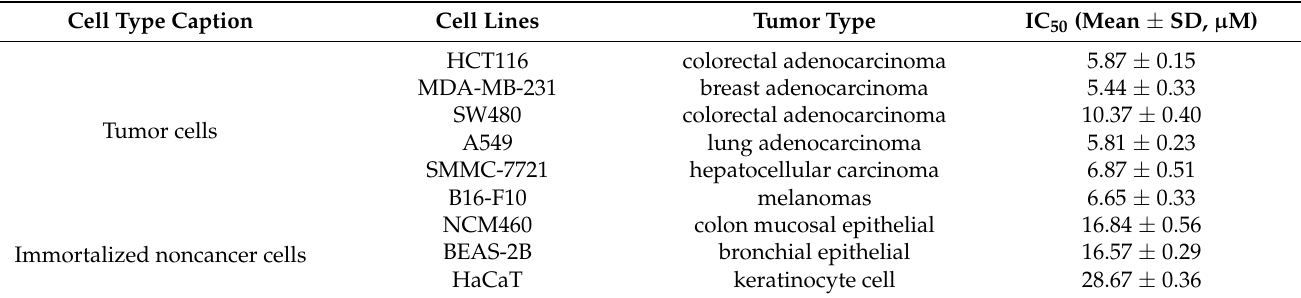
Figure 2. Brevinin-1RL1 preferentially suppressed cancer cells. The cell viability of Brevinin-1RL1 on different tumor cell lines (HCT116, MDA-MB-231, SW480, A549, SMMC7721, B16-F10) ( a ) and three non-tumor cell lines (HaCaT, NCM460 and BEAS-2B) ( b ) were determined by MTS assay. Tumor cells seeded in 96-well plates were incubated with various concentrations of Brevinin-1RL1 for 48 h and the cell viability was measured by MTS. ( c ) The cell viability of tumor cell lines treated with various concentrations of Brevinin-1RL1 red was measured. ( d ) The erythrocyte viability of Brevinin-1RL1 on human erythrocytes was detected by hemolytic activity. Equal volume of Brevinin-1RL1 and human erythrocytes were incubated for 30 min, the absorbance of the supernatant was measured at 540 nm. Each experimental data is three independent experiments. Table 2. The IC 50 of Brevinin-1RL1 against different